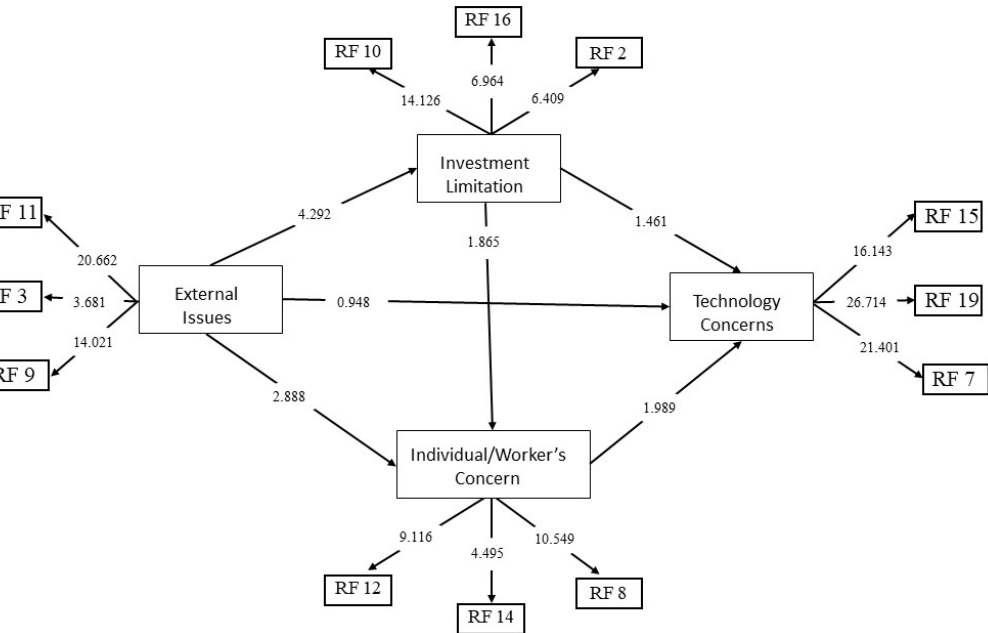
Figure 6. Structural model assessment using a bootstrapping procedure.